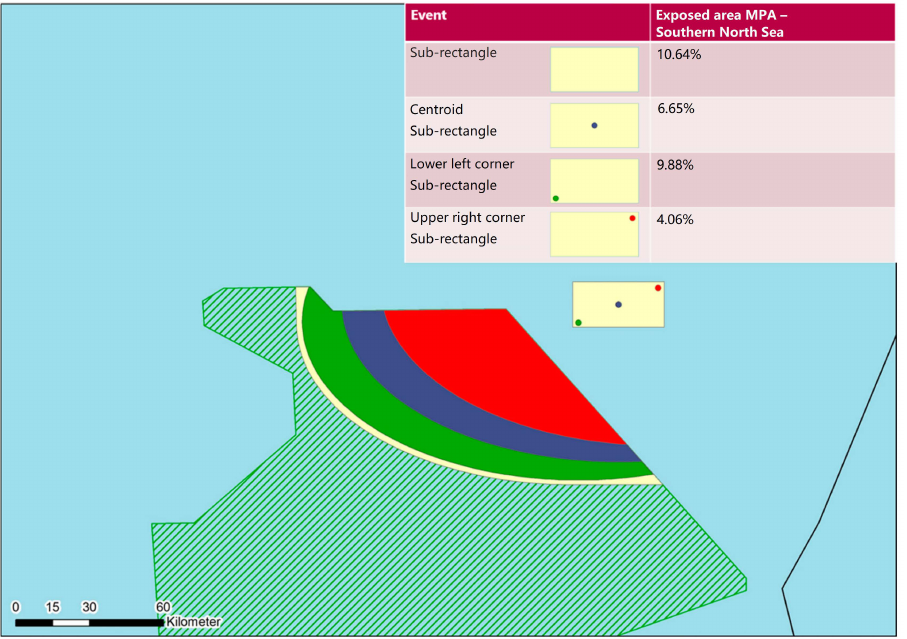
Figure 6. Change of exposed area depending on position description: (( yellow ) complete rectangle, ( green ) lower left corner, ( blue ) centroid, ( red ) upper right corner).